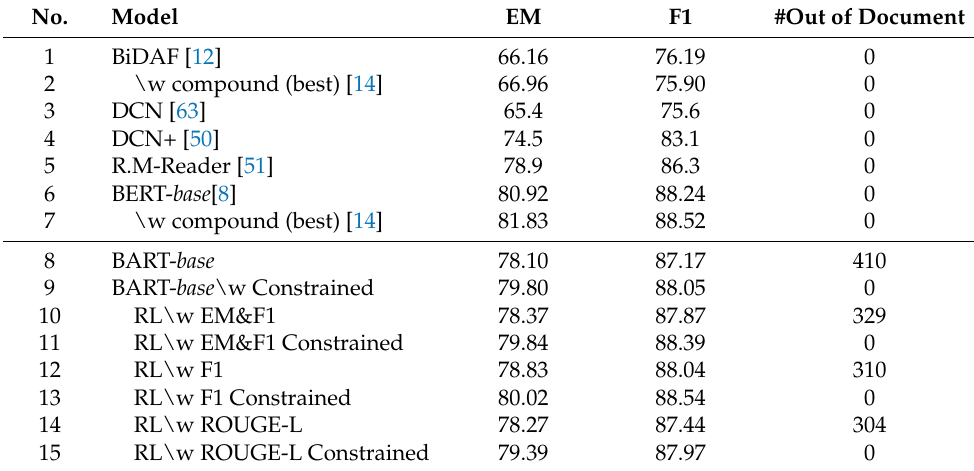
Table 3. The experimental results on the SQuAD